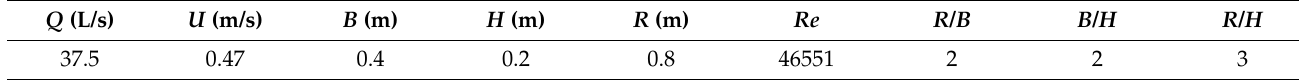
Table 1. Hydraulic conditions for the main flow.